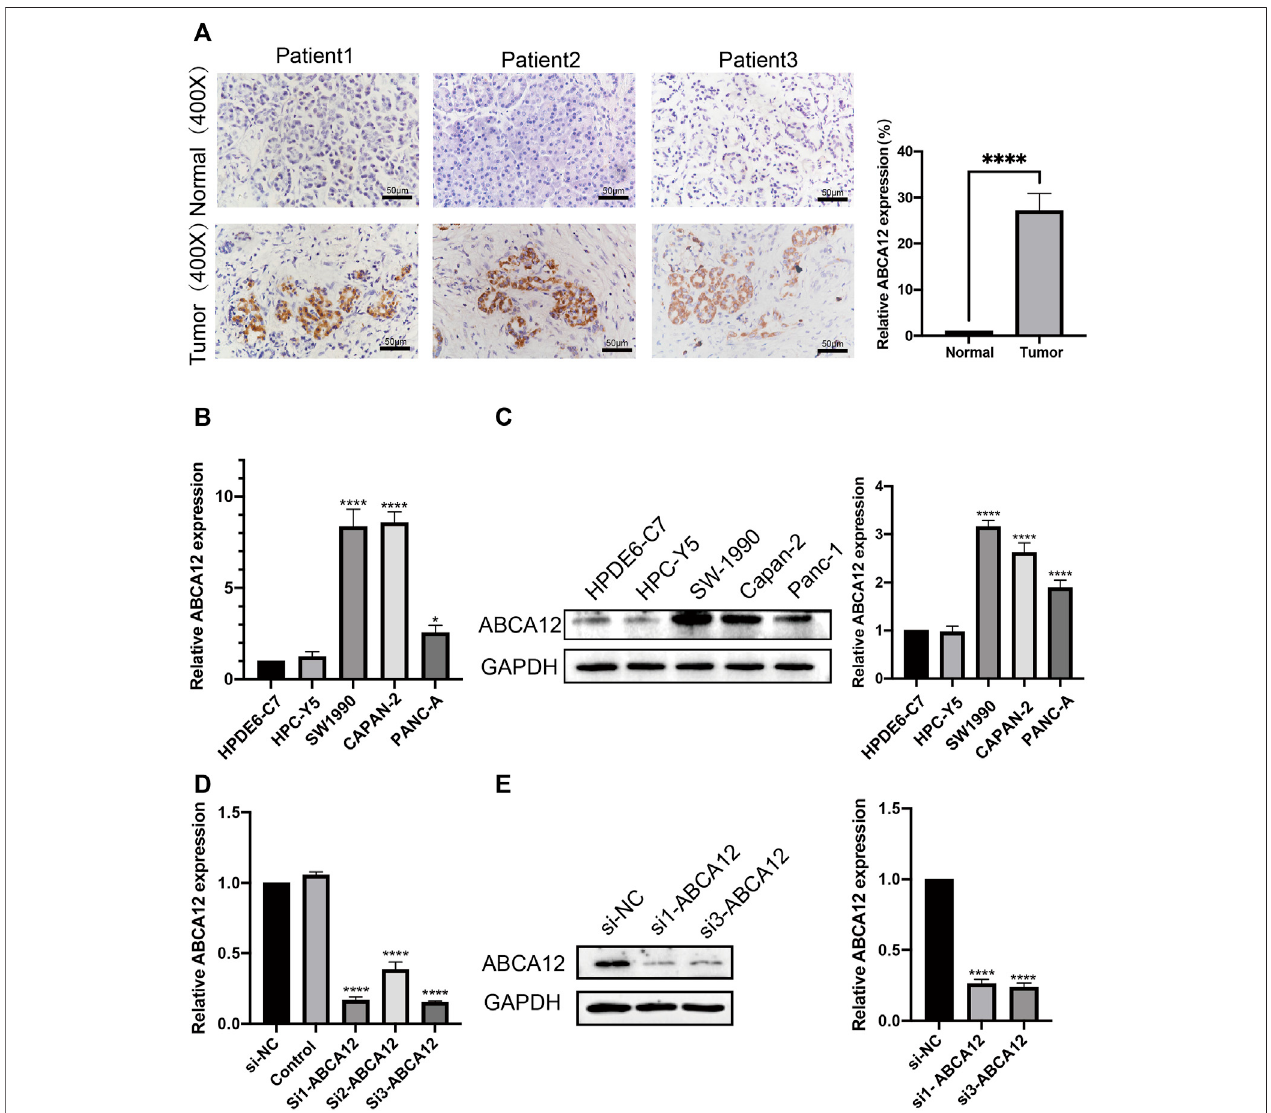
FIGURE 3 | mRNA and protein expression of ABCA12 in pancreatic cancer. (A) IHC results manifested that ABCA12 was highly expressed in pancreatic cancer tissues. (B,C) The expression of ABCA12 mRNA and ABCA12 protein in pancreatic cancer cells was higher than that in normal pancreatic cells. (D,E) ABCA12 in SW1990 cells was effectively knocked down by siRNA, and si1- ABCA12 and si3- ABCA12 had the best knockdown ef fi ciency.